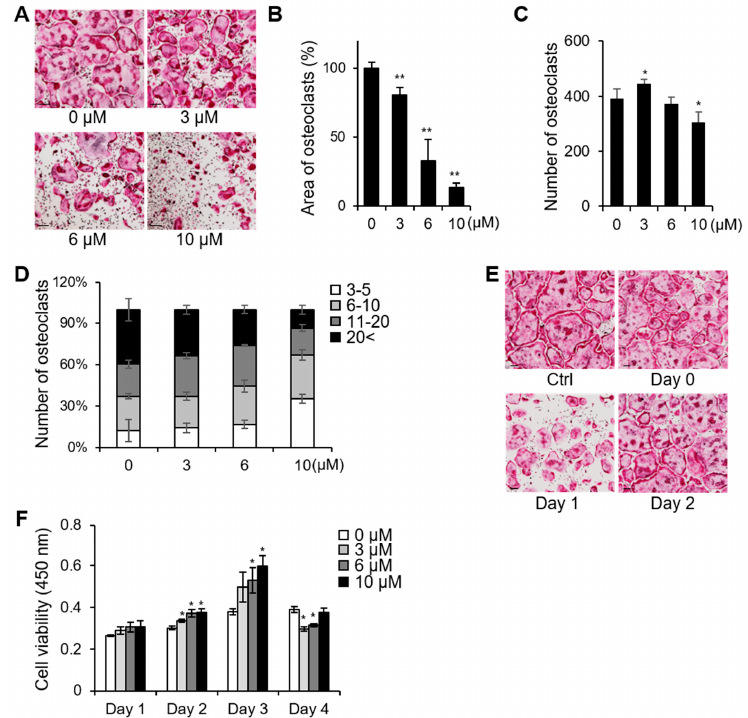
Figure2. PSTP-3,5-Meinhibitedosteoclastdi ff erentiation. ( A )BMMsweredi ff Figure 2 . PSTP-3,5-Me inhibited osteoclast differentiation. ( A ) BMMs were differentiated into osteoclasts in the presence of 3, 6, or 10 µM PSTP-3,5-Me for three days. TRAP staining was performed